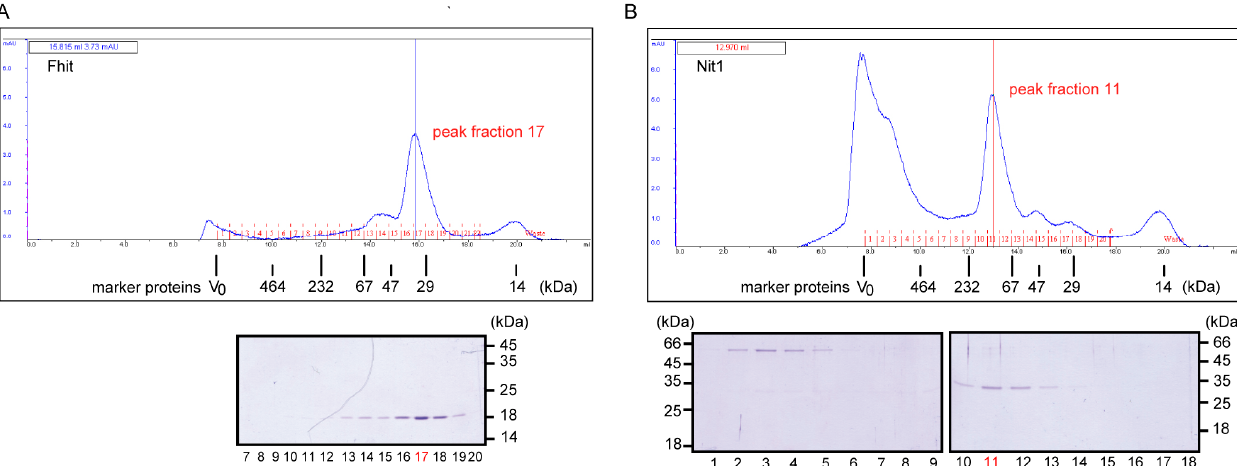
Figure 3. Oligomerization of Fhit ( A ) and Nit1 ( B ). Purified recombinant proteins were analyzed by size exclusion chromatography on a Superdex™200-HR column. Molecular masses of molecular weight marker proteins β -galactosidase (464 kDa; 9.99 mL), catalase (232 kDa; 12.02 mL), bovine serum albumin Fr.V (67 kDa; 13.73 mL), ovalbumin (47 kDa; 14.63 mL), carboanhydrase (29 kDa; 15.9 mL), and lysozyme (14 kDa; 20 mL) are indicated at their corresponding elution volume. Fhit (15.8 mL) and Nit1 (12.9 mL) protein in peak fractions marked in red were separated by SDS-PAGE and detected by subsequent Coomassie blue staining. The elution profiles of molecular weight standard proteins are summarized in Appendix Figure A2.